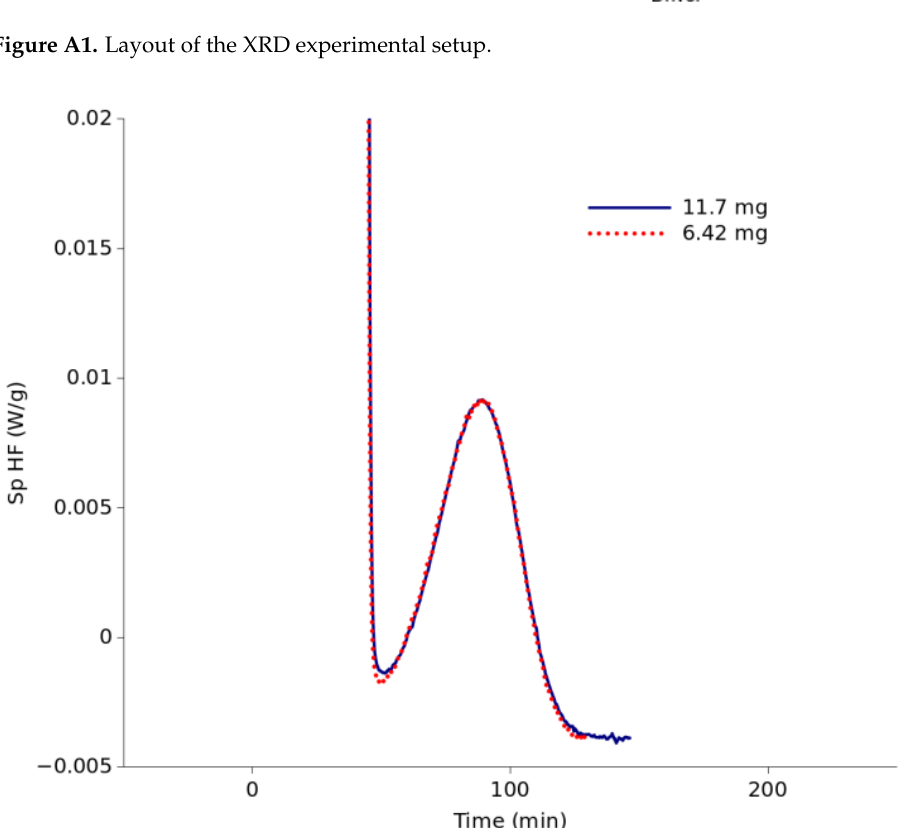
Figure A2. DSC isothermal plots obtained from the melt at 100 °C with 6.42 and 11.70 mg samples.